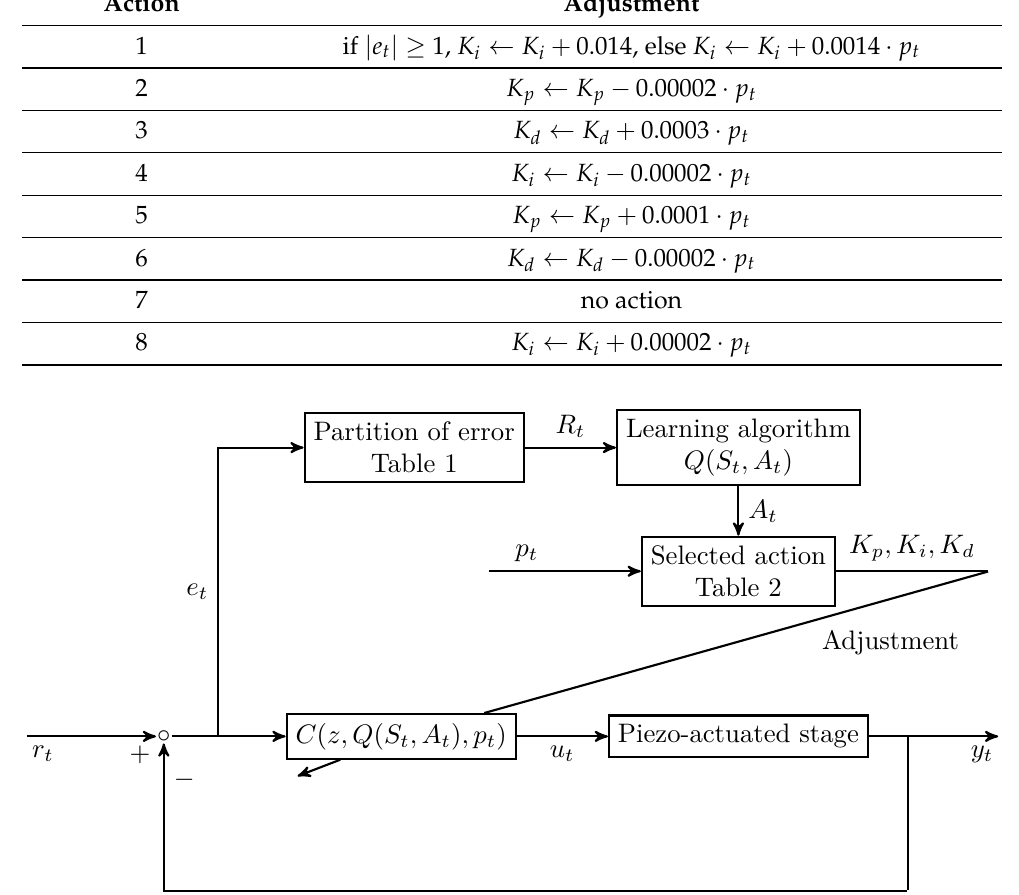
Figure 4. Closed-loop control system